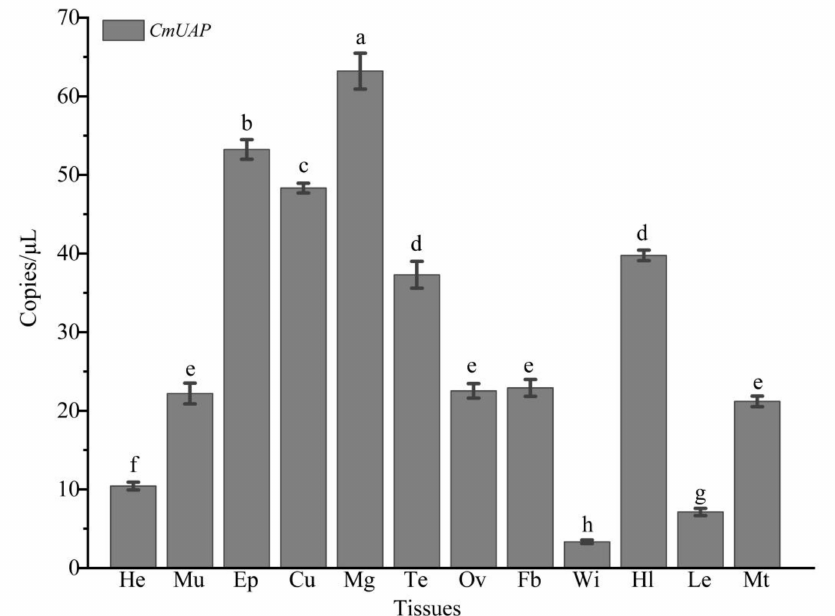
Figure 5. Expression levels of CmUAP in various tissues of C. medinalis adults. He, Head; Mu, Muscle; Ep, Epidermis; Cu, Cuticle; Mg, Midgut; Te, Testis; Ov, Ovary; Fb, Fat body; Wi, Wing; Hl, Hemolymph; Le, leg; Mt, Malpighian tubule. Each bar represents the mean ± SD. Different letters above bars indicate significant differences at p < 0.05 based on Duncan’s